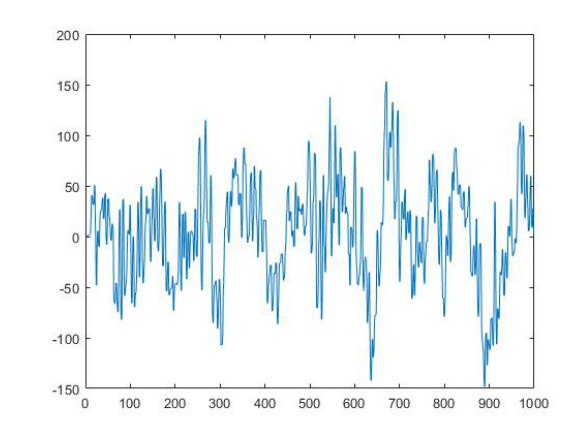
Figure 19. chb05-03 Median Filter